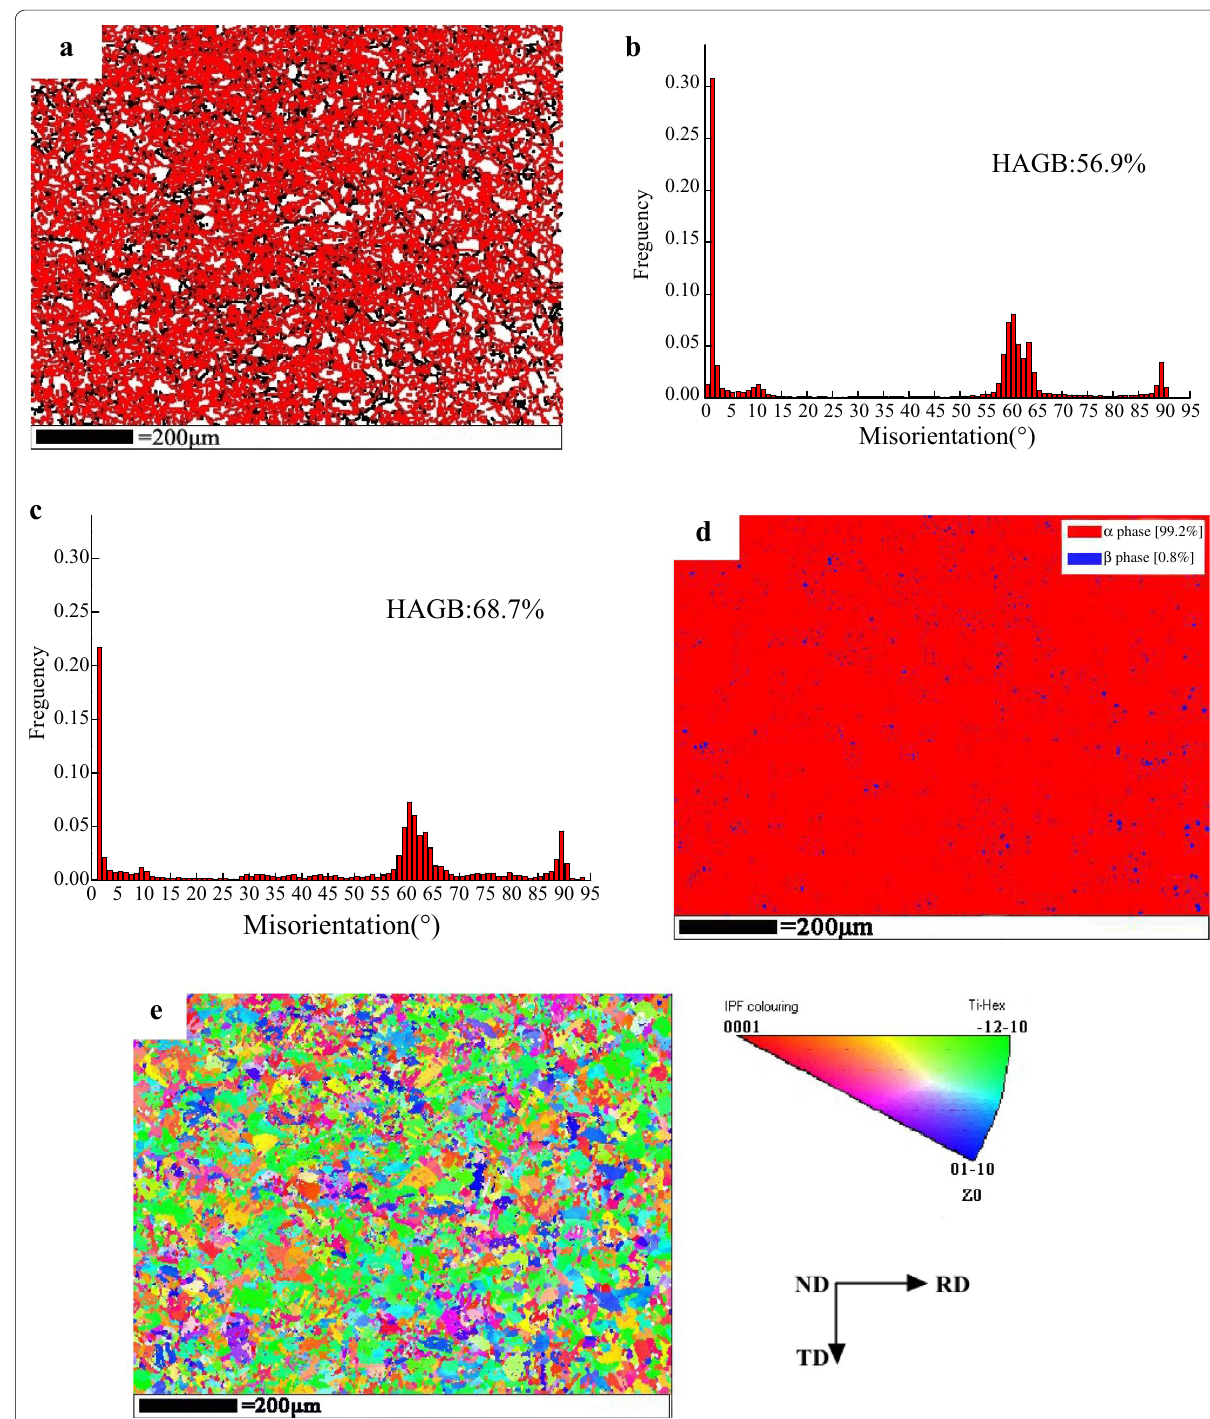
Figure 7 EBSD maps of weld zone: a Grain boundary misorientation angle; b Misorientation angle distribution of WZ; c Misorientation angle distribution of base material; d Phase distribution map; e Inverse pole